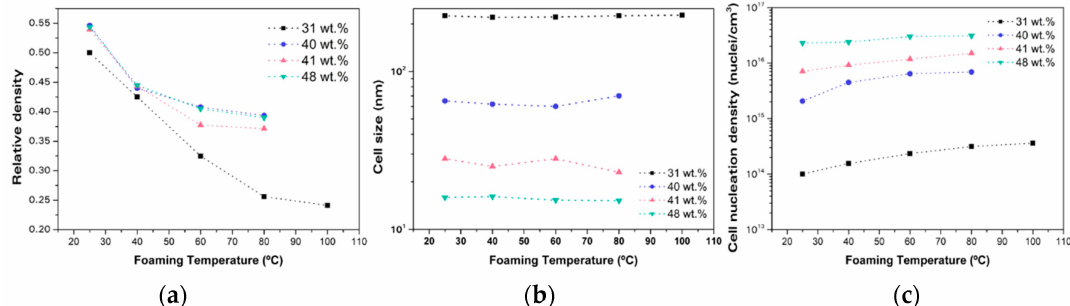
Figure 2. ( a ) Relative density as a function of the foaming temperature for 1 min of foaming time for homogeneous PMMA; ( b ) cell size as a function of the foaming temperature for 1 min of foaming time for homogeneous PMMA; and ( c ) cell nucleation density as a function of the foaming temperature for 1 min of foaming time for homogeneous